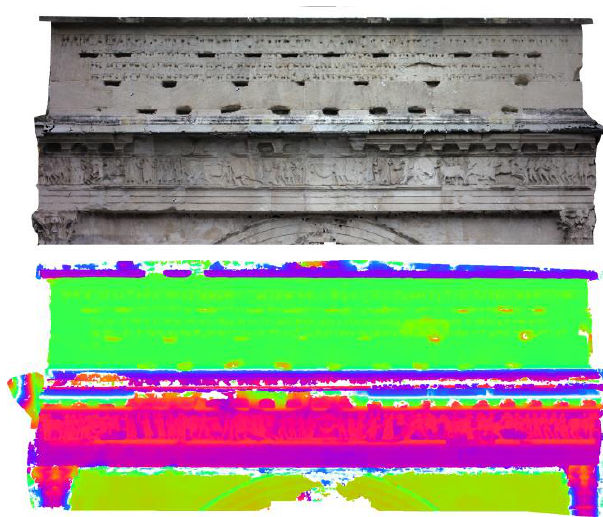
Table 2 - Results of Photoscan (high settings) and MicMac model reconstruction processing